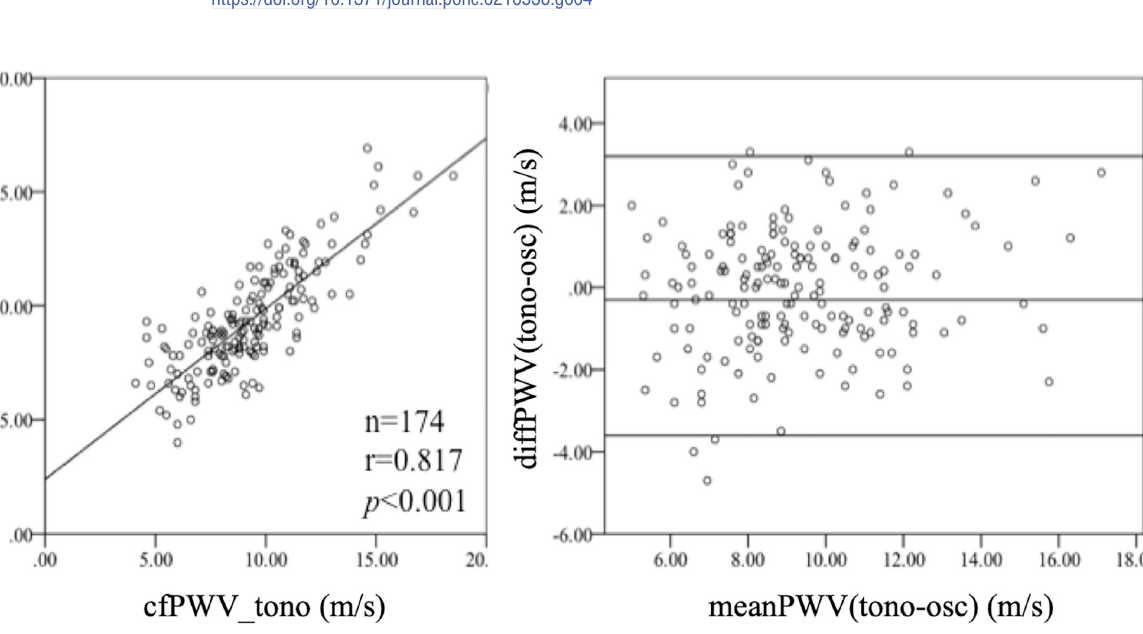
Fig 5. The oscillometric (osc) and tonometric (tono) assessments of the carotid-femoral pulse wave velocity (cfPWV) show a good overall correlation. The left graph shows the correlation between the cfPWV determined by both methods. The right graph shows the corresponding Bland– Altman plot of the agreement between tonometric and oscillometric assessments of the